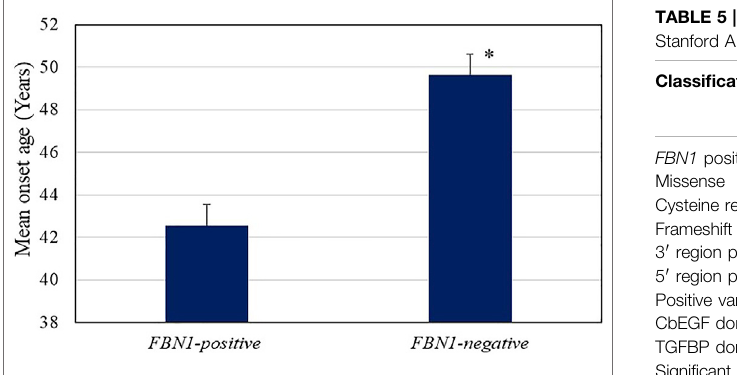
FIGURE 2 | Age of onset of AD in the FBN1 positive variant (42.55 ± 6.95 years) and negative groups (49.63 ± 10.31 years, p (cid:1) 0.03). The error bars indicate standard error.